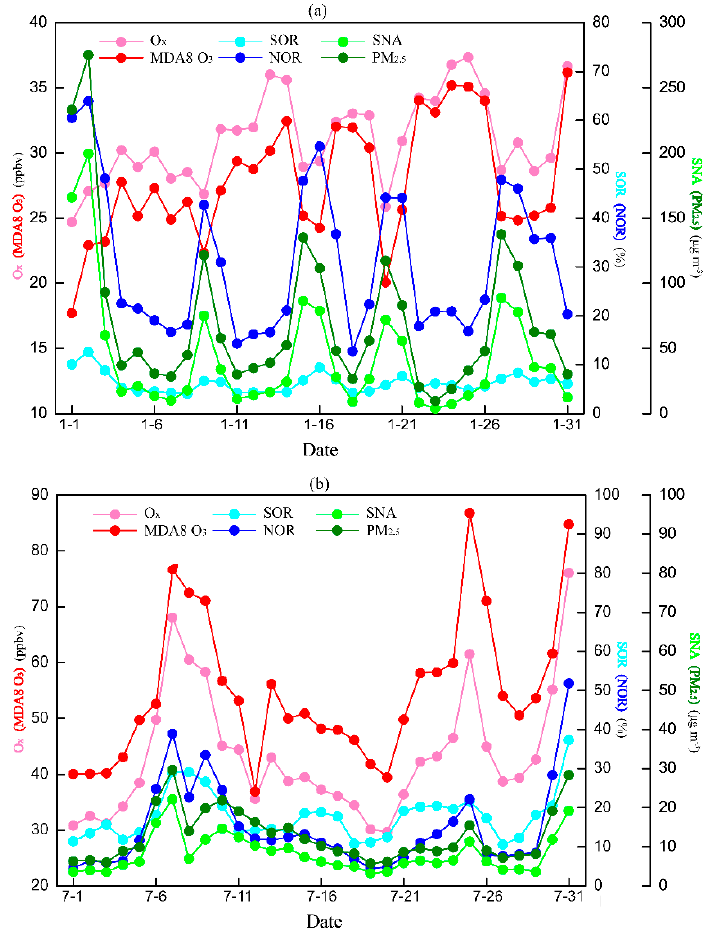
Figure 7. Time-series of simulated daily total oxidant (O x ) and MDA8 O 3 concentrations, sulfur oxidation ratio (SOR) and nitrogen oxidation ratio (NOR), as well as secondary inorganic particles (SNA) and PM 2.5 concentrations for ( a ) BTH in January and ( b ) PRD in July. The O x = O 3 + NO 2 , SOR = n-SO 4 2 − / (n-SO 4 2 − + n-SO 2 ), NOR = n-NO 3 − / (n-NO 3 − + n-NO 2 ), SNA = SO 4 2 − + NO 3 − + NH 4 + .